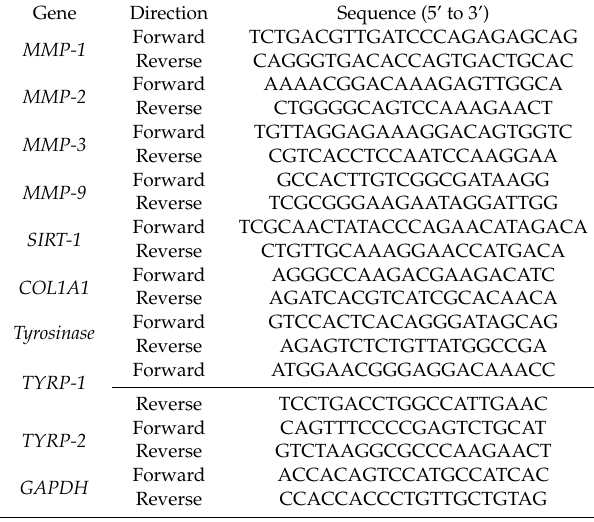
Table 1. Sequences of primers (human) used in semiquantitative